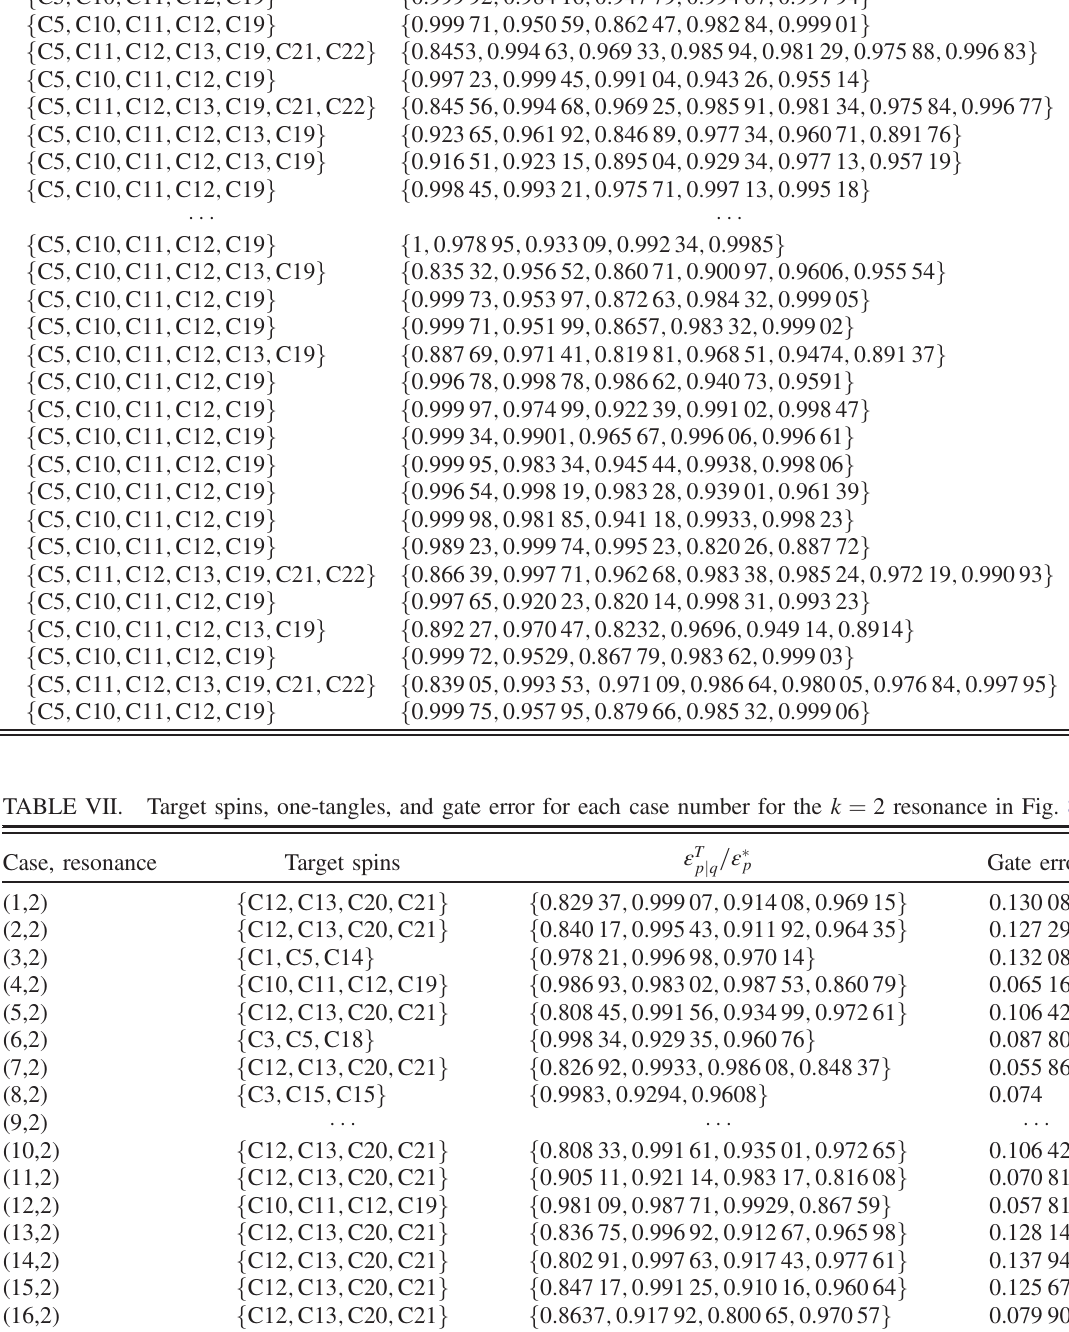
TABLE VI. Target spins, one-tangles, and gate error for each case number for the k ¼ 1 resonance in Fig. 8. Case, resonance